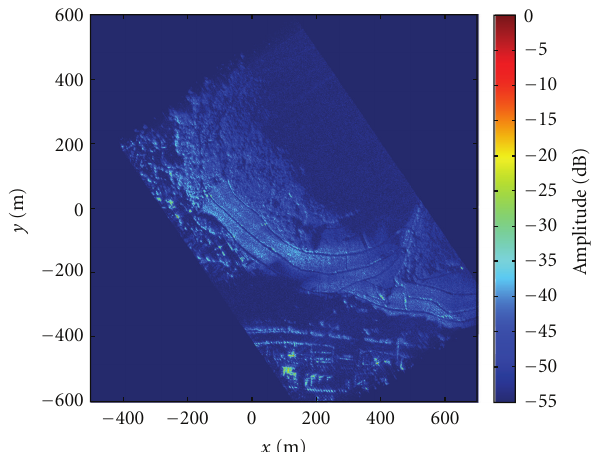
Figure 9: Example of a SAR image with a resolution of 50 cm ×